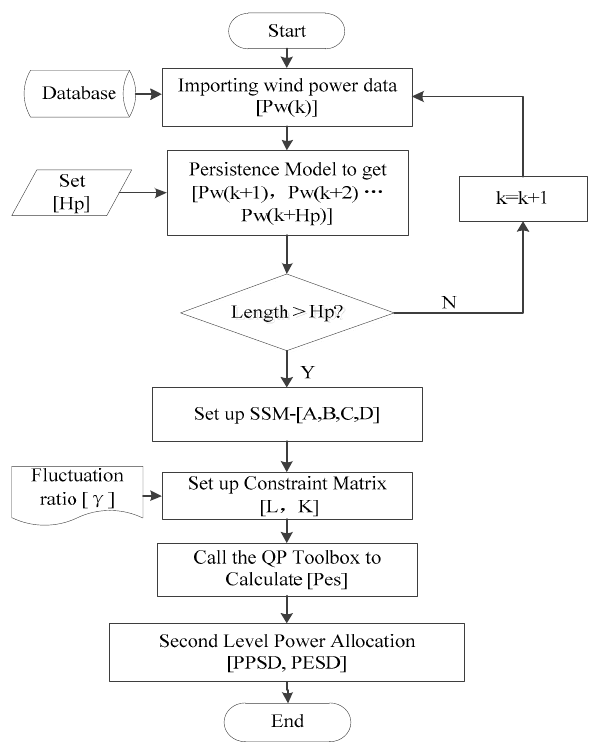
Figure 5. Flowchart of the MPC-based coordinated control algorithm.